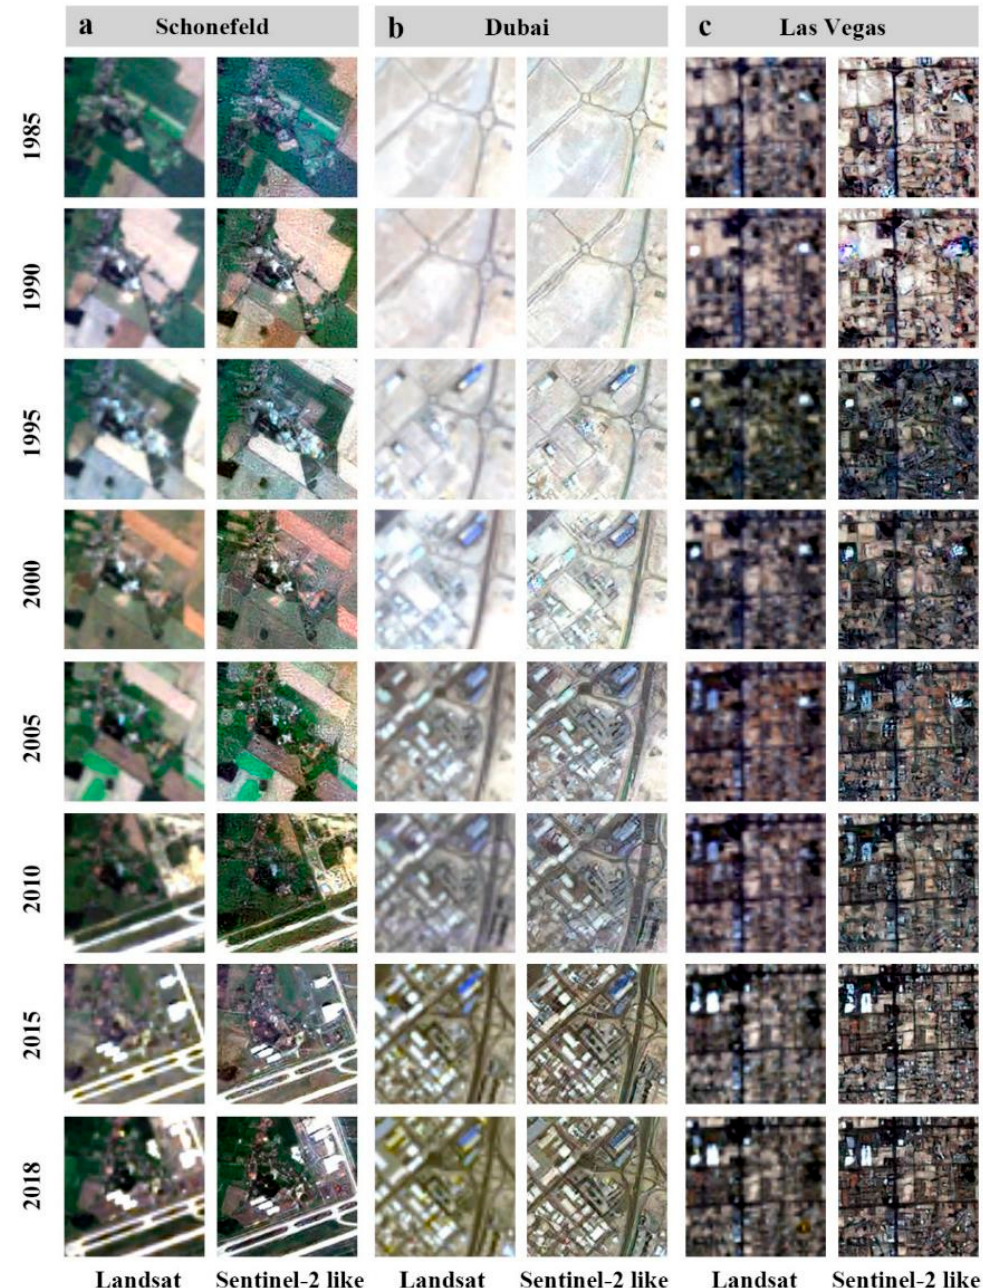
Figure 12. Zoomed-in comparison between Landsat and reconstructed 10 m Sentinel-2-like images in ( a ) Schonefeld, ( b ) Dubai, and ( c ) Las Vegas from 1985 to